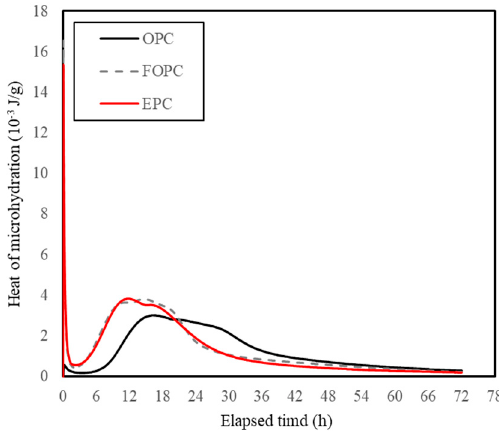
Figure 11. Heat of micro-hydration observed for OPC, FOPC, and EPC.